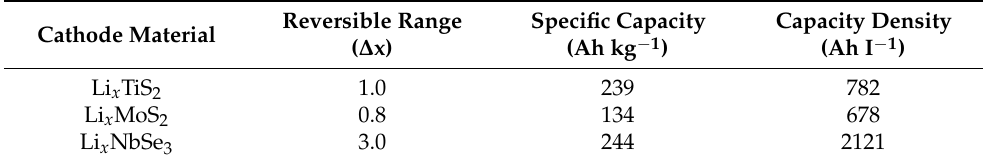
Table 1. Range of reversibility and theoretical specific capacity and capacity density of